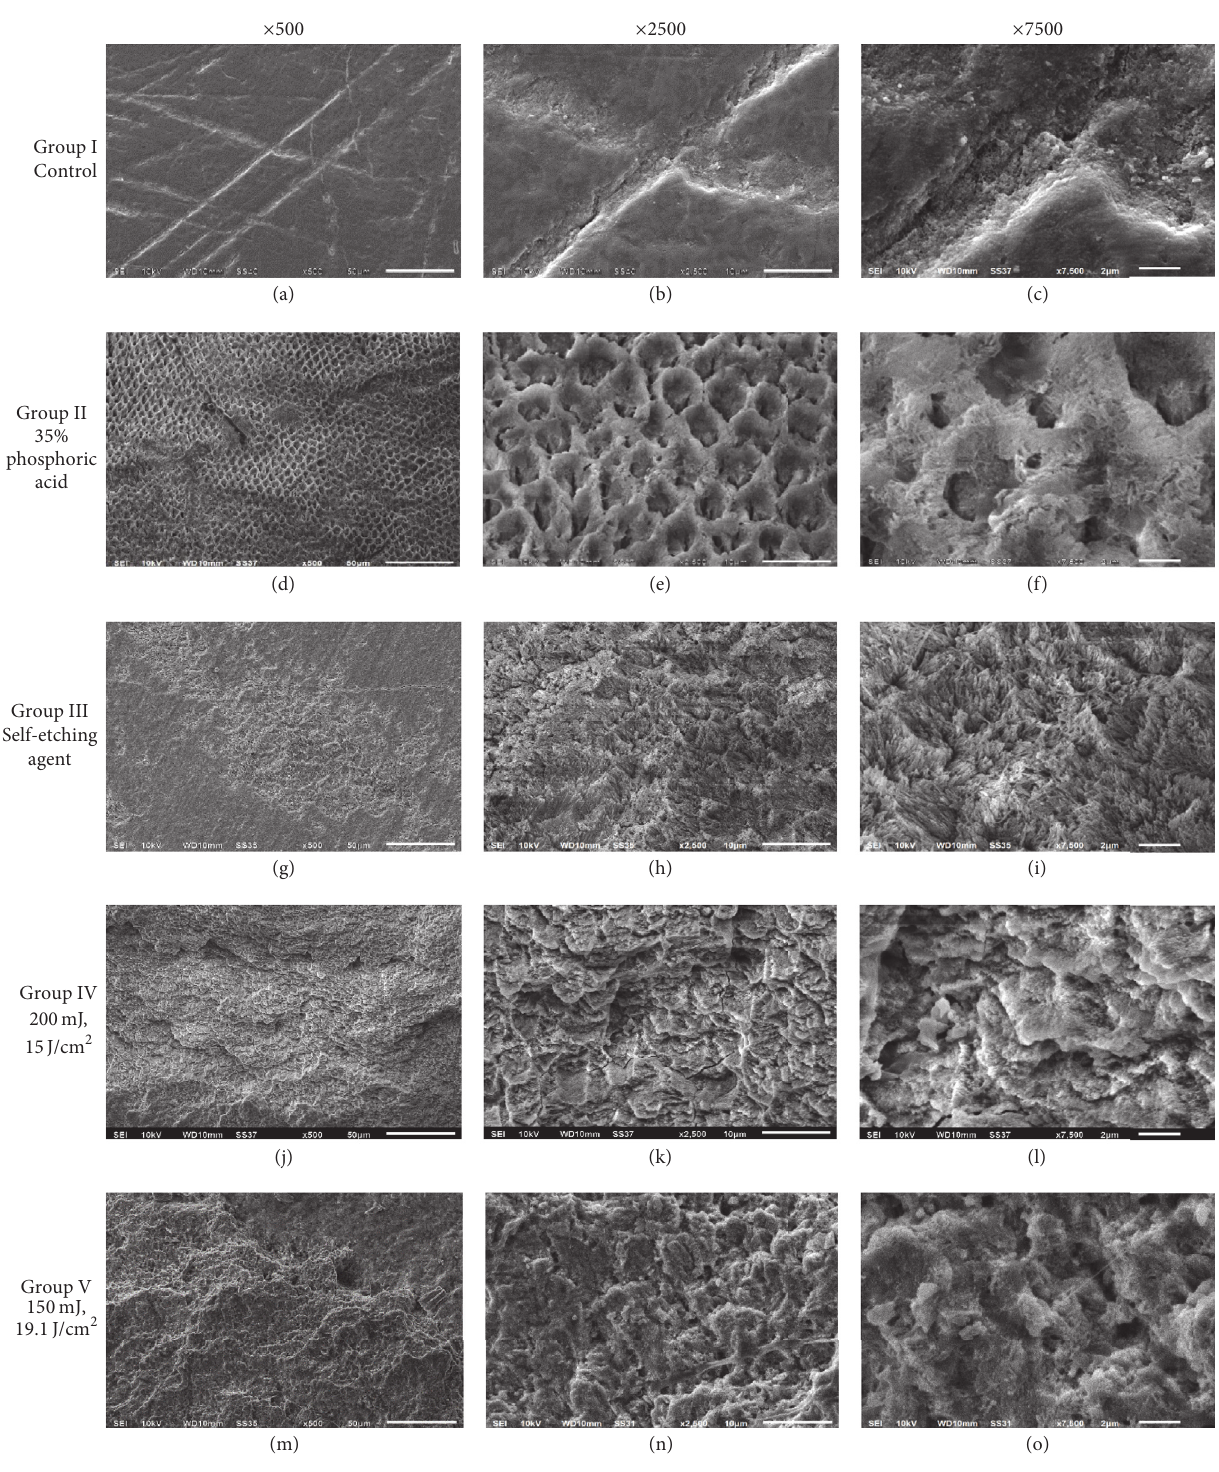
Figure 2: SEM micrographs of untreated (control) and conditioned surfaces of primary enamel. Group I (a, b, c) presented a smooth pattern with some enamel grooves. A traditional honeycomb etching pattern was observed when 35% phosphoric acid conditioning was employed (group II, d, e, f). Group III (g, h, i) exhibited rough zones and exposed prisms produced by self-etching agent. Exposed prisms and flakes, resultinginaroughscalysurfaceafterEr:YAGlaserirradiationat15 J/cm 2 (j,k,l)and19.1 J/cm 2 (m,n,o)(groupsIVandV,resp.),microcracks, and small areas of enamel ablation (original magnifications, × 500, × 2500, × 7500); scale bar = 50 𝜇 m, 10 𝜇 m, and 2 𝜇